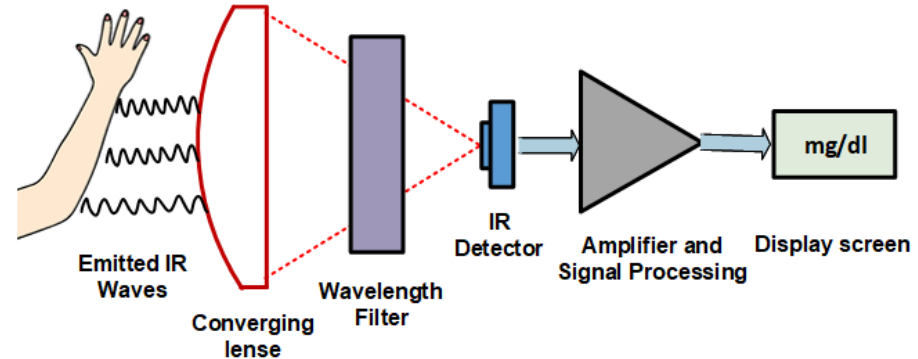
Figure 3. Thermal Emission Spectroscopy.